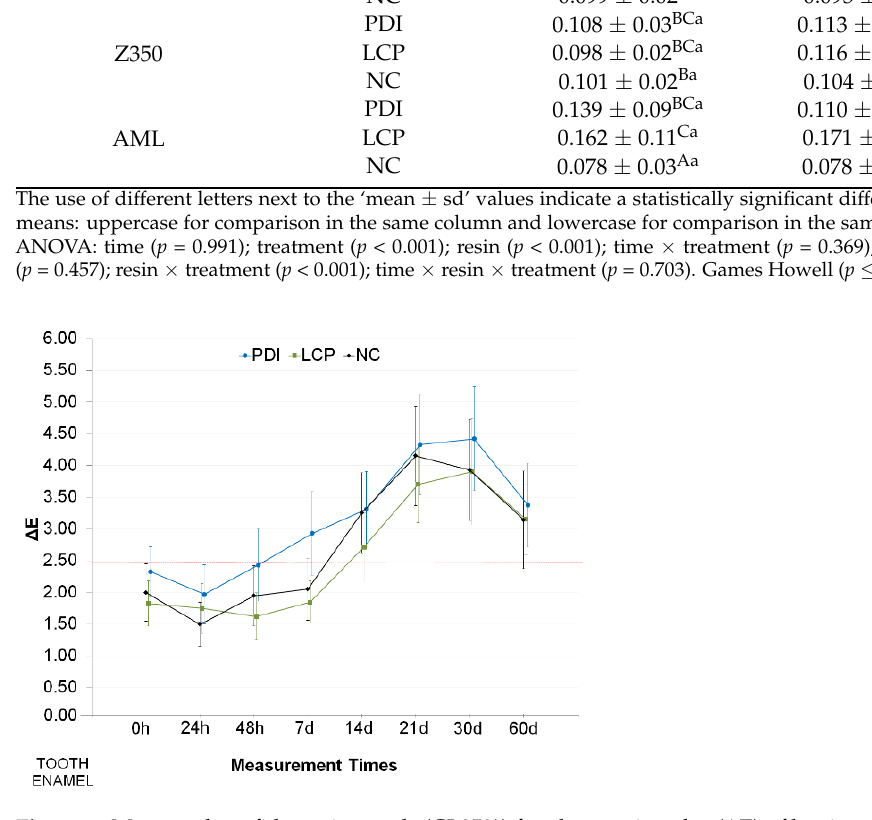
Figure 4. Mean and confidence intervals (CI 95%) for changes in color ( Δ E) of bovine tooth enamel test specimens obtained following treatment (PDI: curcumin-mediated photodynamic inactivation